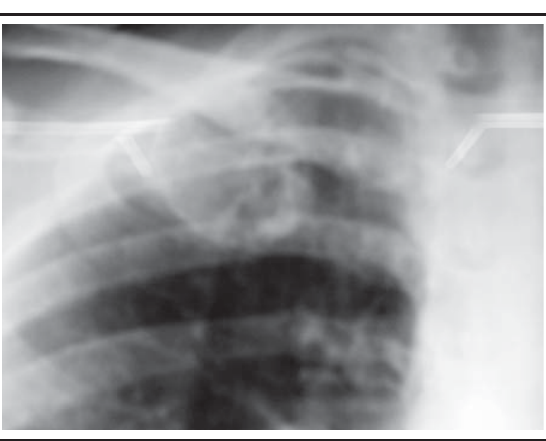
Figure 2. X-Ray chest showing mass arising from 1 st rib anteriorly